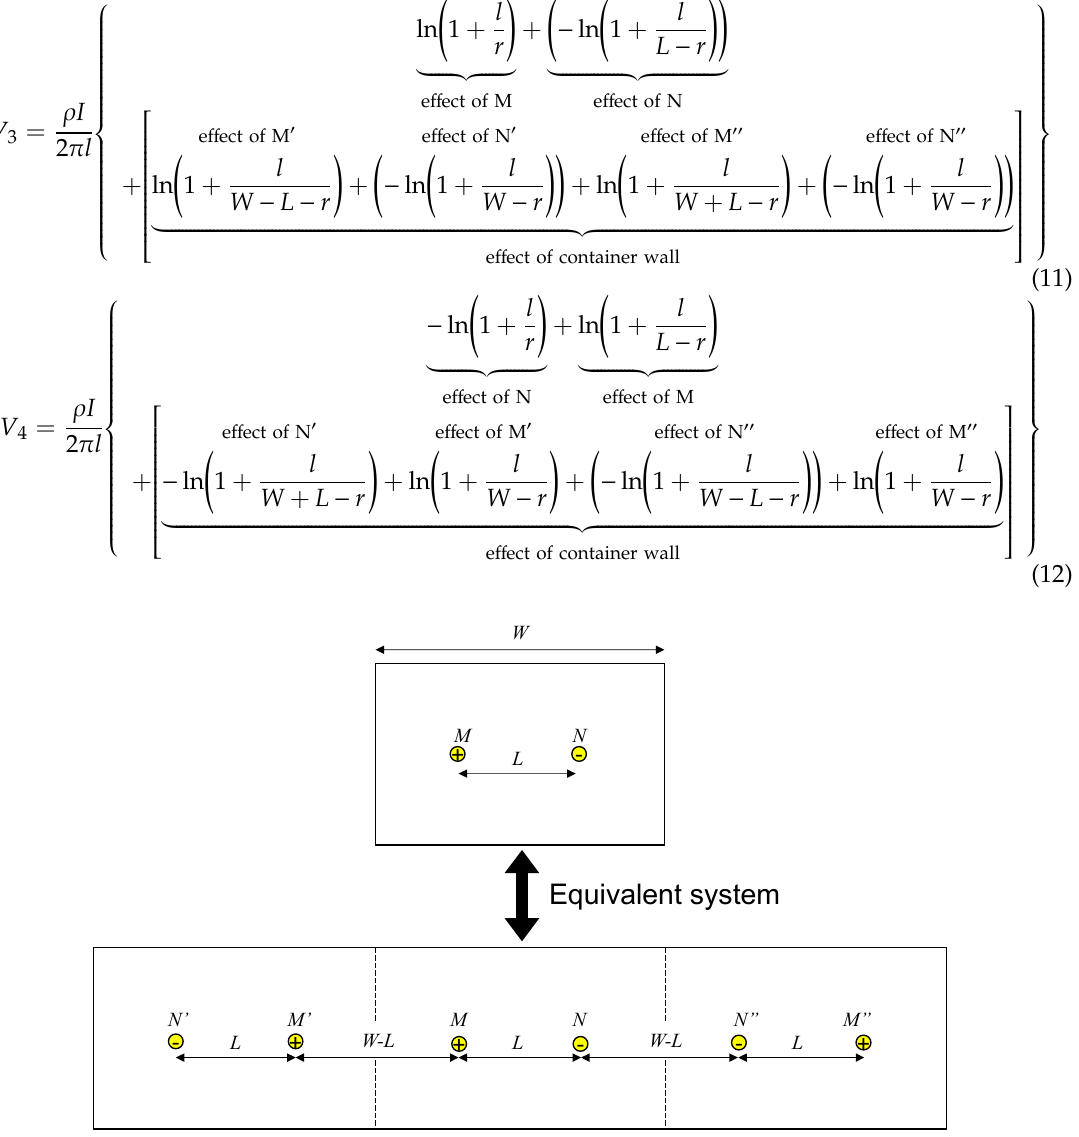
Figure 2. Basic concept of imaginary electrodes.